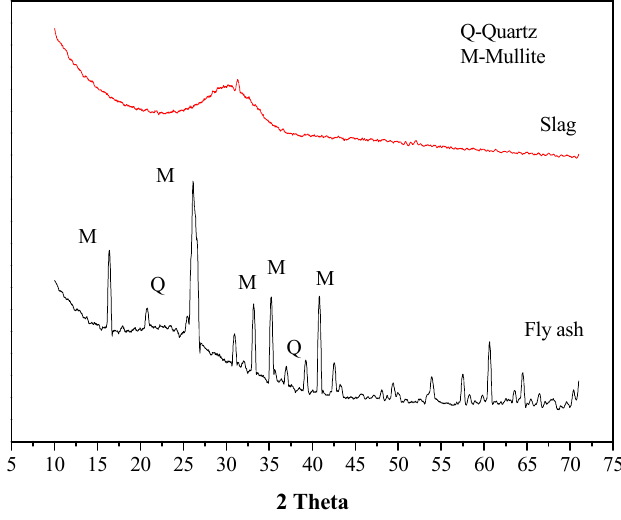
Figure 1. XRD of raw materials.